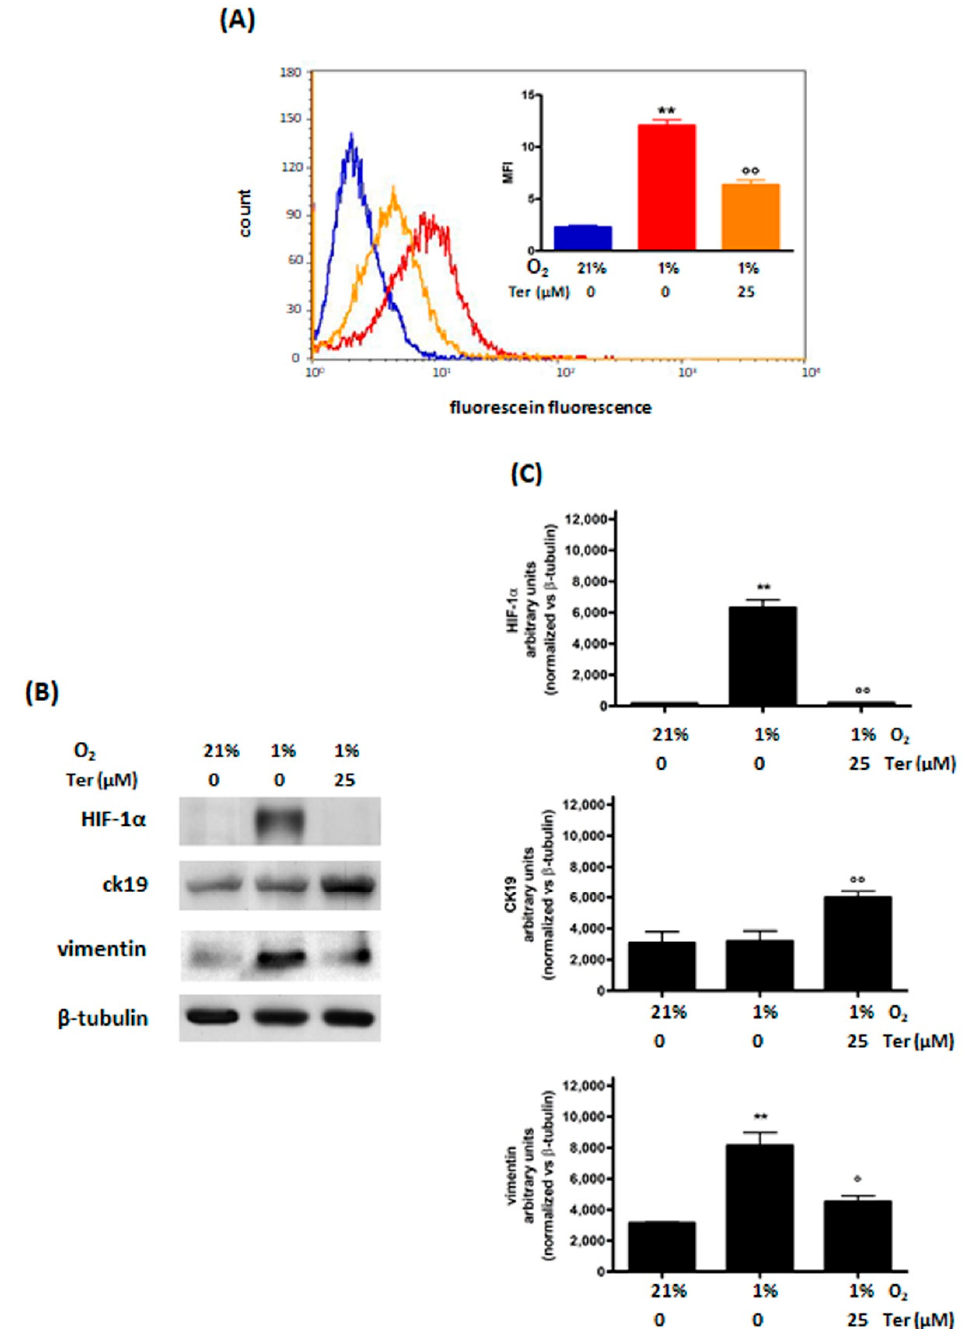
Figure 4. Effects of 48 h of treatment with Ter (25 µ M) and incubation in normoxia (O 2